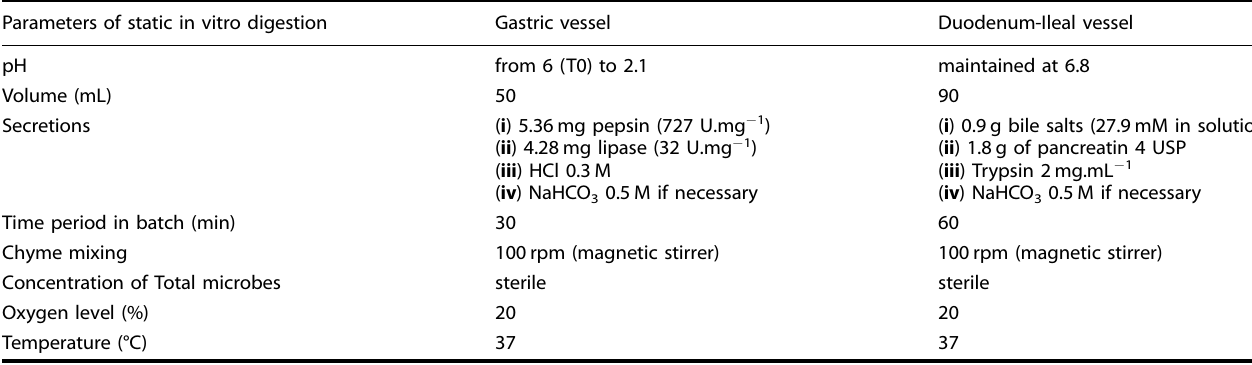
Table 1. Static in vitro gastro-ileal digestion